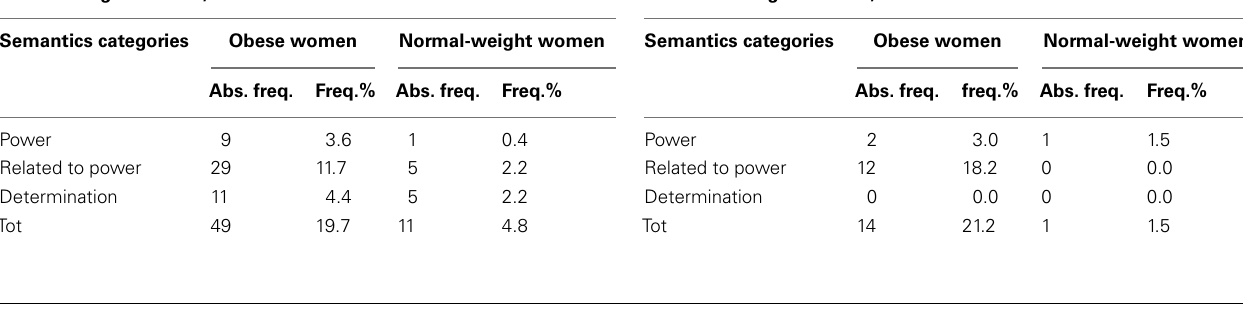
Table 2 |Absolute frequencies and percentages of constructs related to power for each group (GroupA: obese women and Group B: normal-weight